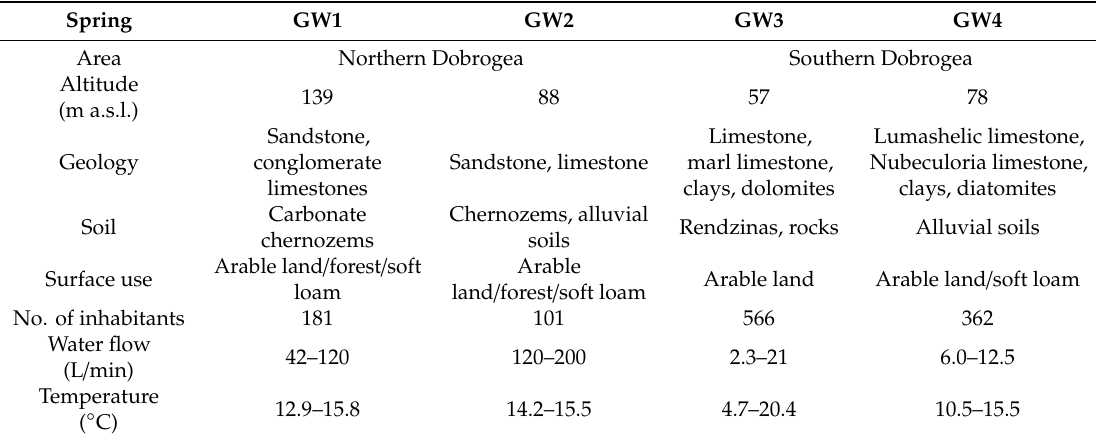
Figure 1. ( A ) Dobrogea map with the location of the four karstic springs. ( B ) Representation of the village’s administrative boundaries and the sampling points GW1—Praporgescu and GW2—Closca; ( C ) Representation of the village’s administrative boundaries and the sampling points GW 3—Sipote and GW4—Tufani. Table 1. Geology and geographic particularities of the tested springs area [29].